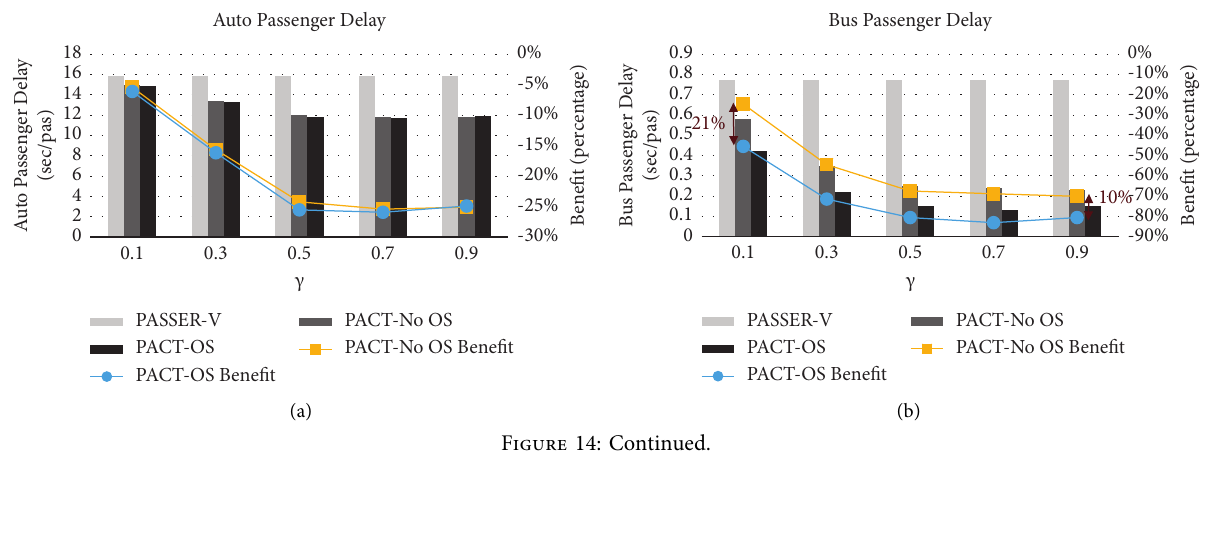
BenefitPASSER-V PACT-OS PACT-OS Benefit